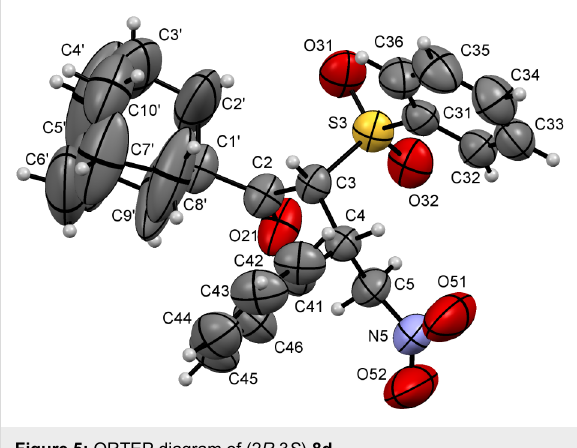
Figure 5: ORTEP diagram of (2 R ,3 S )- 8d